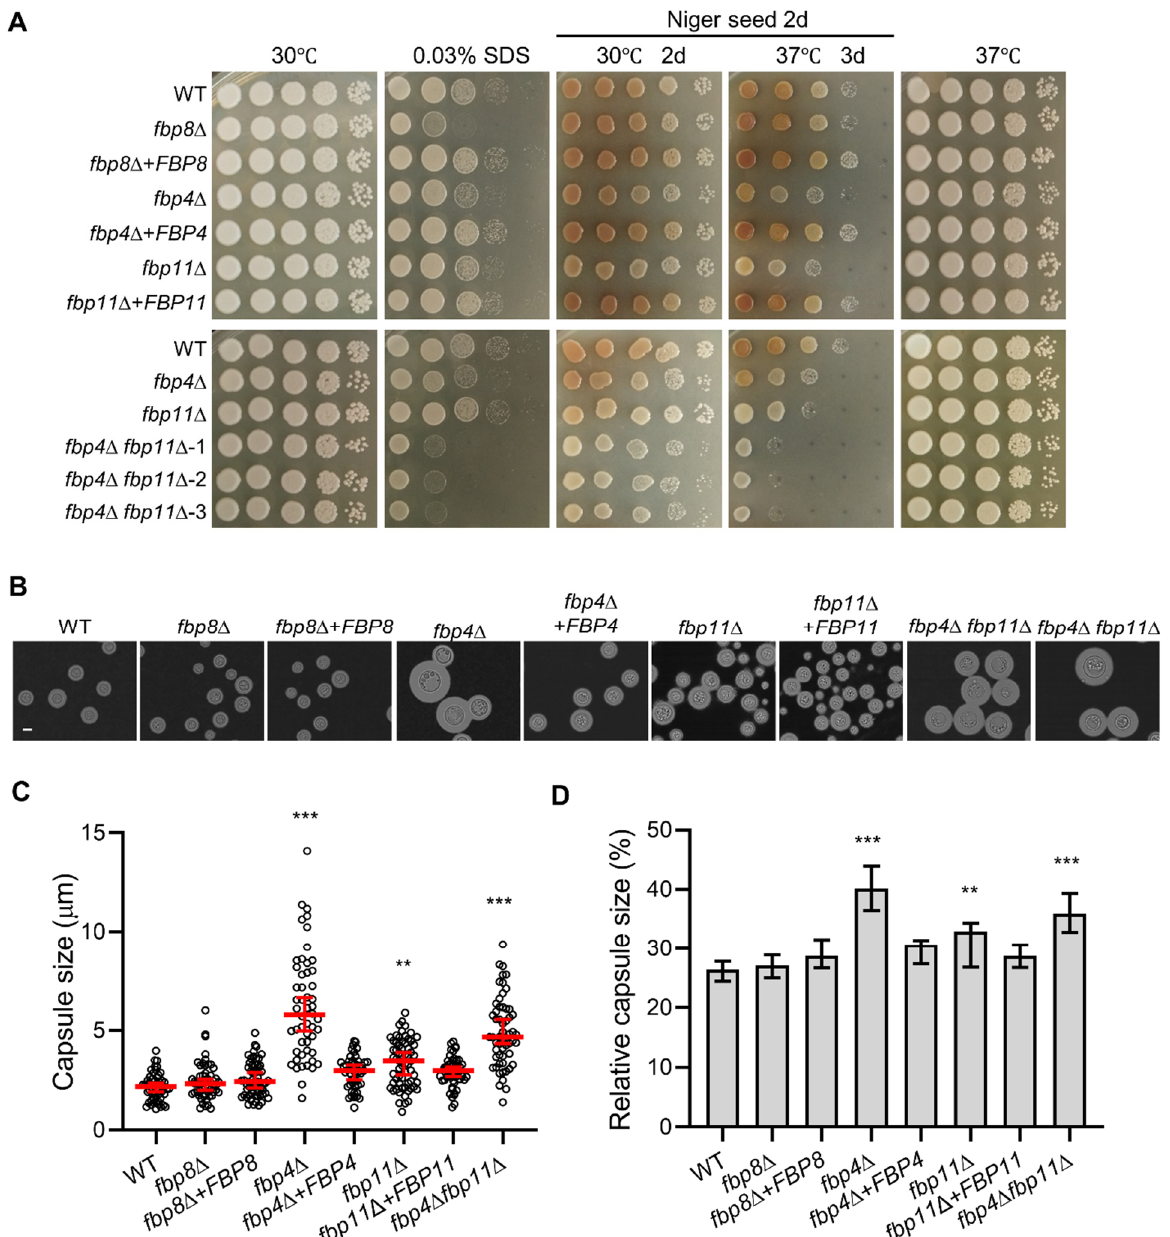
Figure 2. F-box proteins are required for cell integrity and development of virulence factors. ( A ) Cell membrane stress and melanin production assays. Overnight cultures were collected and resuspended to an optical density at 600 nm (OD600) of 10.0. Tenfold serial dilutions were made in ddH 2 O, and 5 µ L of each were plated on 0.03% SDS or Niger seed agar. Plates were incubated at 37 ◦ C or 30 ◦ C for 2 or 3 days. ( B ) Representative images to show capsule formation at 37 ◦ C on DME medium. Capsule production was visualized by India ink staining after cells were grown on DME medium for 7 days. Bar, 5 µ m. ( C ) Capsule size was measured by India ink staining. ( D ) Relative capsule size was calculated by dividing observed capsule size by whole-cell size. The average and standard deviation from at least 50 cells were calculated for each condition tested. WT, wild type. Statistical analysis for all measurements in this figure was performed with the Kruskal–Wallis nonparametric test for multiple comparisons. **, p ≤ 0.01. ***, p ≤